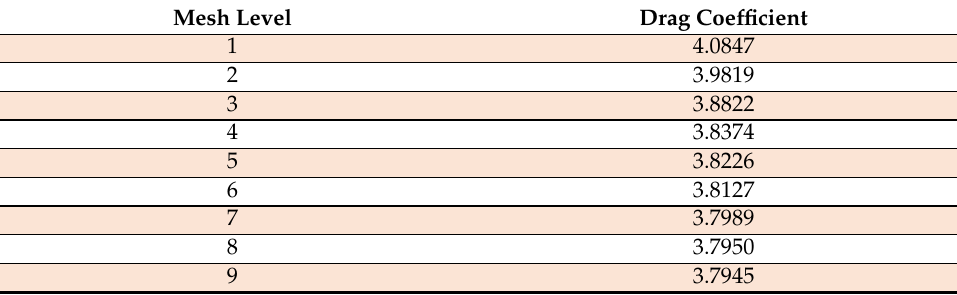
Table 4. Drag coefficient data for Case-II with